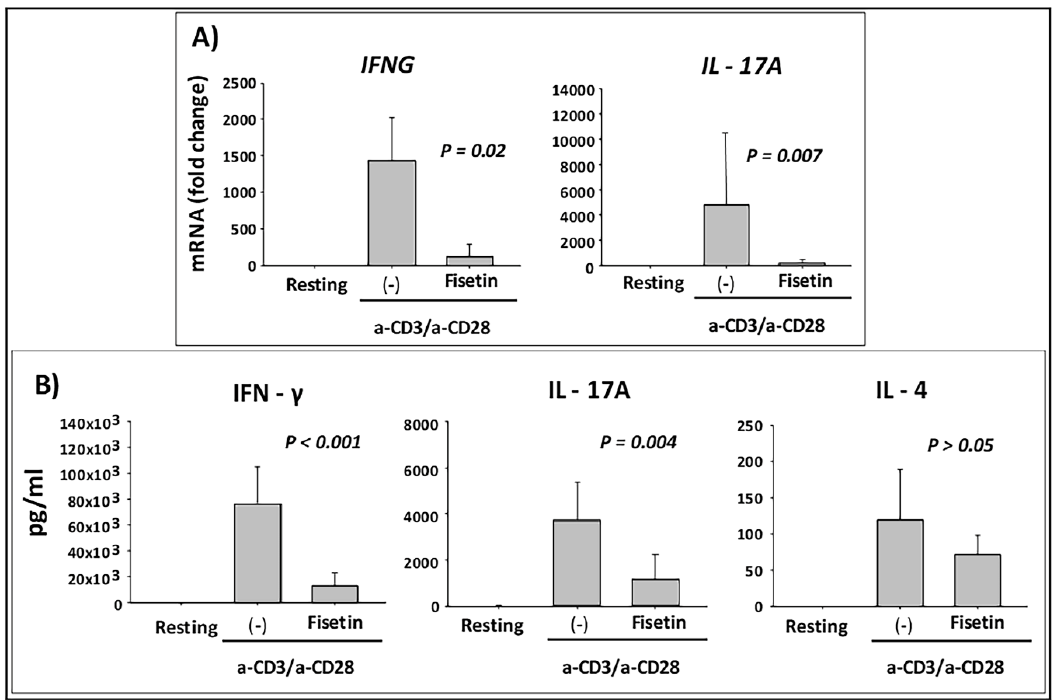
Figure 6. Fisetin suppresses the expression and secretion of IFN- γ and IL-17 in activated human peripheral blood mononuclear cells (PBMC). PBMC were prepared from the circulating blood from three di ff erent healthy blood donors, and were cultured without (resting) or with anti-CD3 plus anti-CD8 (a-CD3 / a-CD28), either treated with 10 µ M of fisetin or the vehicle alone (-) for 10 min before activation. ( A ) PBMC were activated for 6 h before measurement of the type-1 and type-17 proinflammatory cytokines IFN- γ ( IFNG ) and IL-17A ( IL17A ) mRNA expression levels. Fold change in mRNA levels compared to resting cells, whose expression level was fixed at 1, were determined. Means ± SE are shown, and log10 transformation followed by paired t -test was used to compare mRNA levels in a-CD3 / a-CD28-activated PBMC with or without fisetin. ( B ) PBMC were activated for 48 h in the indicated conditions and secreted cytokines (IFN- γ , IL-17A, and IL-4) present in the cell culture media were measured by ELISA. Means ± SD are shown and the paired t -test was used to compare values between fisetin and no fisetin (–) for a-CD3 / a-CD28-activated